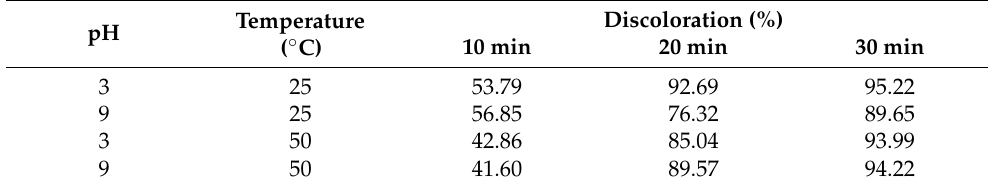
Table 2. Percentage of discoloration for each photocatalysis reaction using the Cu 2 (OH) 3 NO 3 as catalyst.